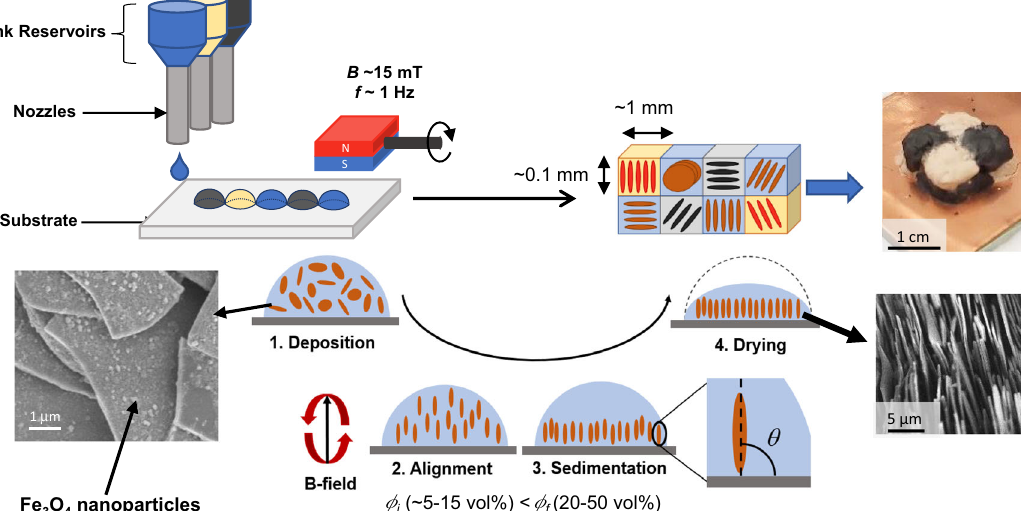
Fig.1|Overviewofmagneticallyassisteddrop-on-demandprinting(MDOD). In MDOD, droplets of inks containing magnetically responsive microplatelets are deposited by a printer and a rotating magnetic fi eld is applied to the printed dro- plets. The bottom left inset shows the electron micrograph of the microplatelets functionalised with superparamagnetic iron oxide nanoparticles to make them magnetically responsive. In summary, the droplets undergo four key steps. After thedropletsaredepositedonthesubstrate(Step1.Deposition),themicroplatelets are aligned by the magnetic fi eld with fi eld strength B and rotational frequency f .